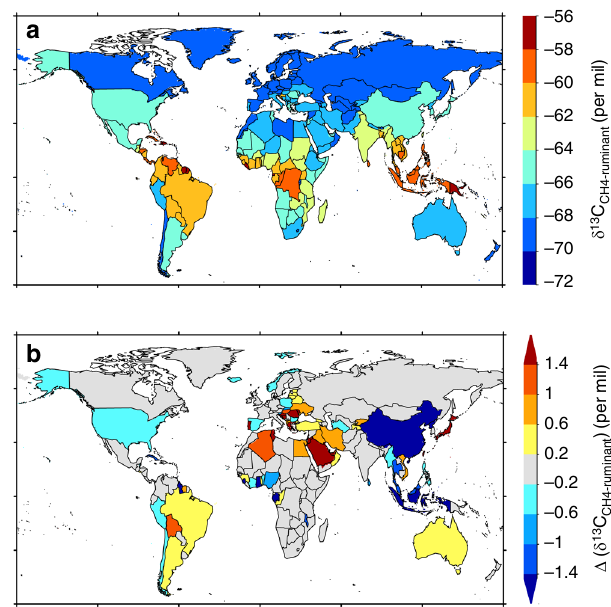
Fig. 5 Country average δ 13 C CH4-ruminant in 2000s, and the changes in δ 13 C Δ ( δ 13 C Δ CH4-ruminant between 1960s and 2000s ( CH4-ruminant )). The ( δ 13 C CH4-ruminant ) is here calculated from the diet shift only (i.e., changes in the relative C3 – C4 fraction in feeds) without accounting for decreasing δ 13 C CO2-atm incorporated in the biomass of grazed plants (see Methods). A positive Δ ( δ 13 C CH4-ruminant ) indicates an increase of δ 13 C CH4-ruminant from 1960s to 2000s from a higher fraction of C4 in the